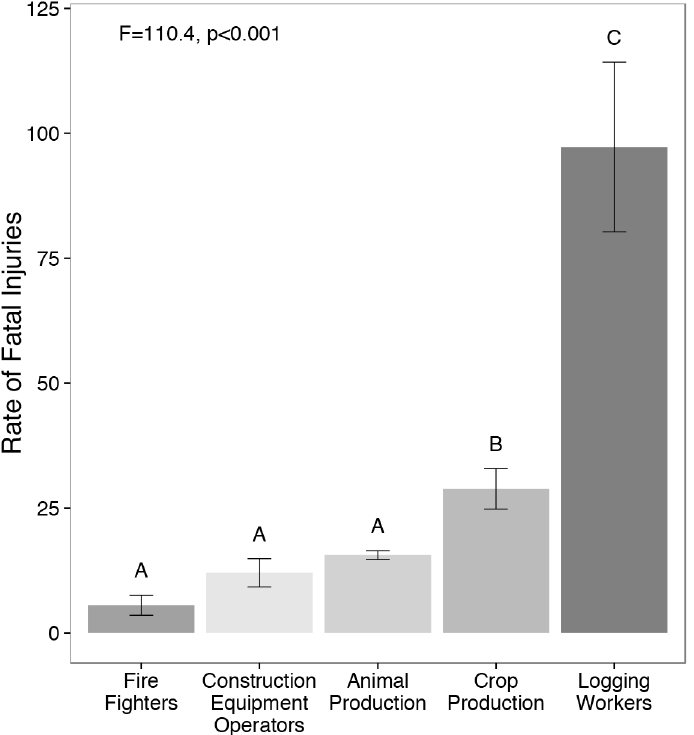
Fig 1. Relative risk of different management techniques used by private land managers, based on occupational fatality rates as proxies. The fatality rate represents the number of fatal occupational injuries per 100,000 full-time equivalent workers. Mean fatality rates and 95% confidence intervals for each occupational proxy for years 2006 – 2013.